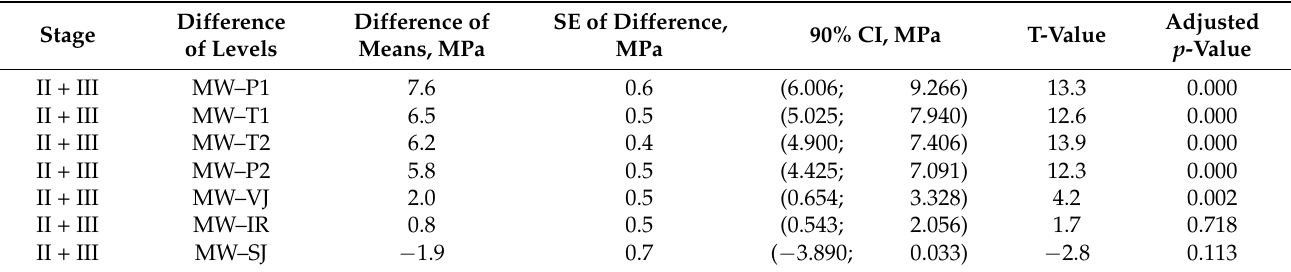
Table 12. Tukey’s pairwise comparison for SCB test, ultimate stress.